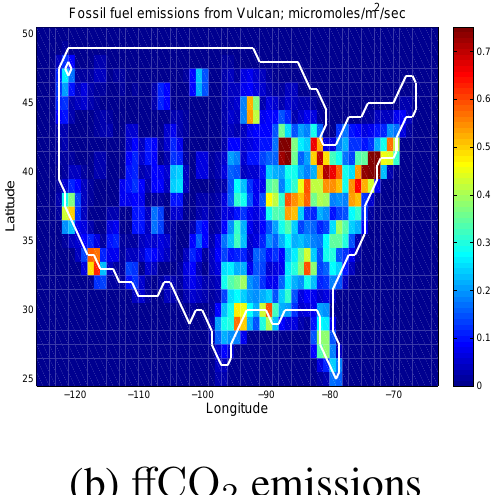
Figure 1. Differences in the spatial distribution of biospheric (top) and fossil-fuel (bottom) CO 2 fluxes. The biospheric fluxes are stationary, whereas ffCO 2 emissions are non-stationary and correlated with human habitation. The fluxes/emissions cover 1–8 June 2002. The biospheric fluxes are obtained from CASA-GFED (http://www.globalfiredata.org/index.html). The post-processing steps to obtain the fluxes as plotted are described in Gourdji et al. (2012). The units of fluxes/emissions are µmols − 1 m − 2 of C. The ffCO 2 emissions are calculated by spatiotemporal averaging of the Vulcan inventory. Note the different color maps; ffCO 2 emissions can assume only non-negative values.